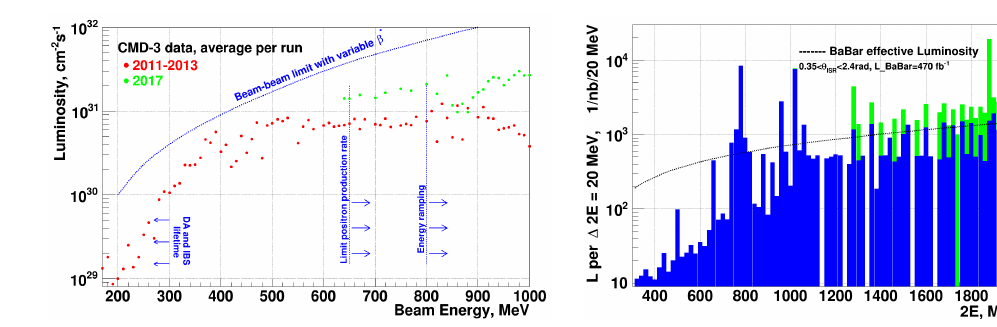
Figure 2. Average luminosity of VEPP-2000 at di ff erent energies. Red points — 2011–2013 runs, green points — 2017 run.